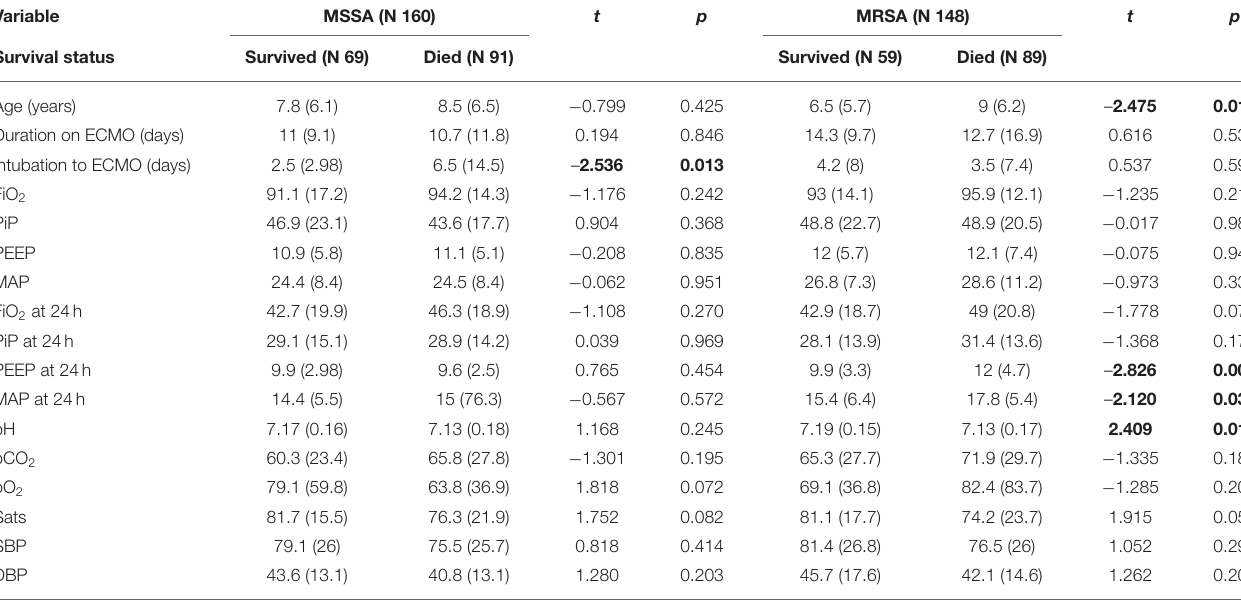
TABLE 2 | Differences in the MSSA and MRSA sepsis cohort on ECMO according to the survival status.